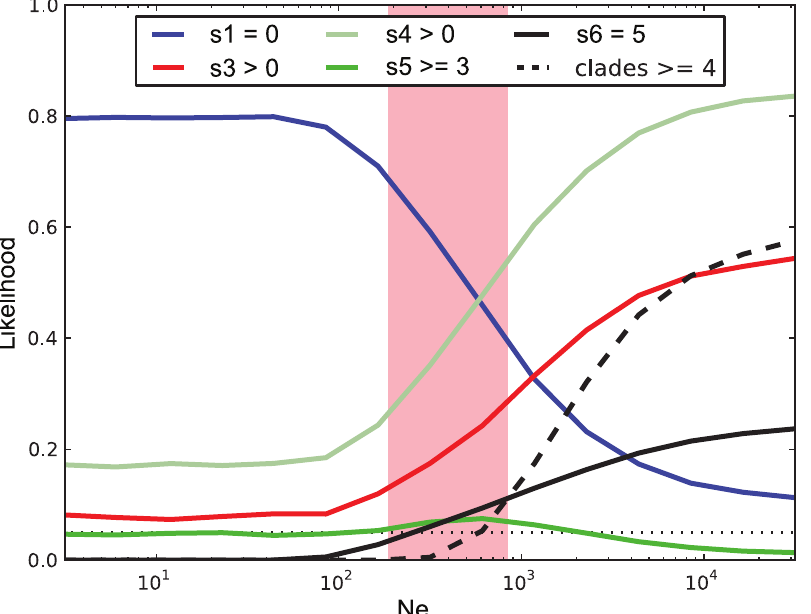
Figure 3. Likelihoods of various aspects of the data under neutral evolution. The pink shaded region denotes the 2 s range of N e (512 6 162) inferred using Fluctuate (Table 1) and the dotted line denotes a cut-off at p =0.05.